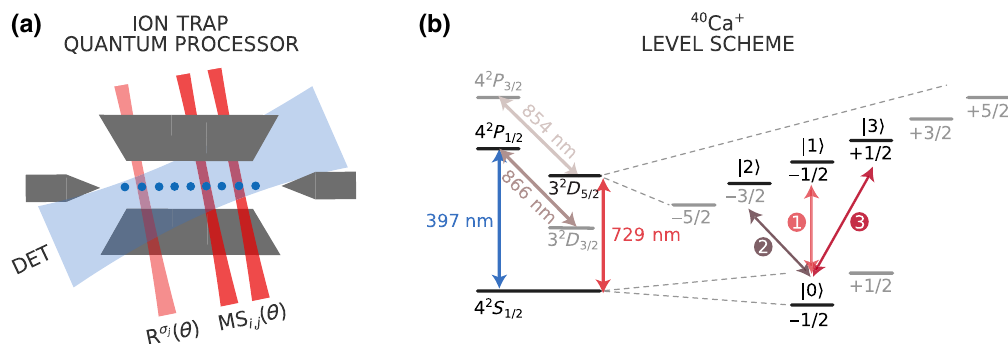
FIG. 6. Schematic of the trapped-ion quantum processor using 40 Ca + . (a) Each ion within the linear string encodes a qubit ( | 0 (cid:4) , | 1 (cid:4) ) or ququart ( | 0 (cid:4) , | 1 (cid:4) , | 2 (cid:4) , | 3 (cid:4) ). A universal gate set is realized upon coherent laser-ion interaction using tightly focused beams, addressing single ions for local gates (bright red) and pairwise ions for entangling gates (dark red). Alternatively, we can globally address all ions simultaneously. Readout is performed via collective fluorescence detection (DET); see the text for details. (b) 40 Ca + level scheme with a dipole transition (397 nm) for cooling and detection, a metastable quadrupole transition (729 nm) for encoding qubits and ququarts within the Zeemann submanifold as well as transitions for repumping at 854 and 866 nm. The labeled transitions (1, 2, 3) provide coherent connection between all ququart